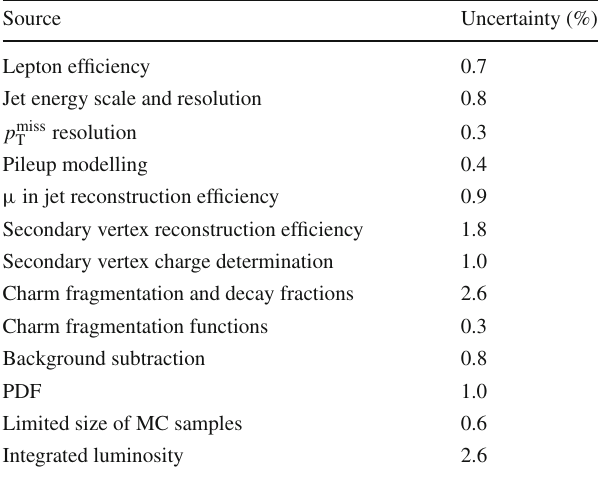
Table 6 Impact of the sources of systematic uncertainty in the com- bined σ( W + c ) measurement